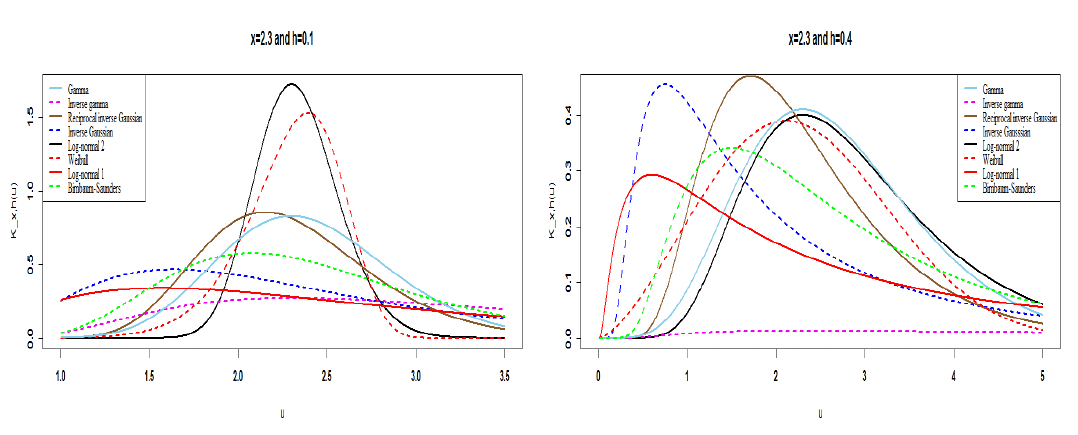
Figure 2. Comparative graphics of the eight univariate semicontinuous associated kernels of Table 1 inside ( x = 2.3) with h = 0.1 and h =